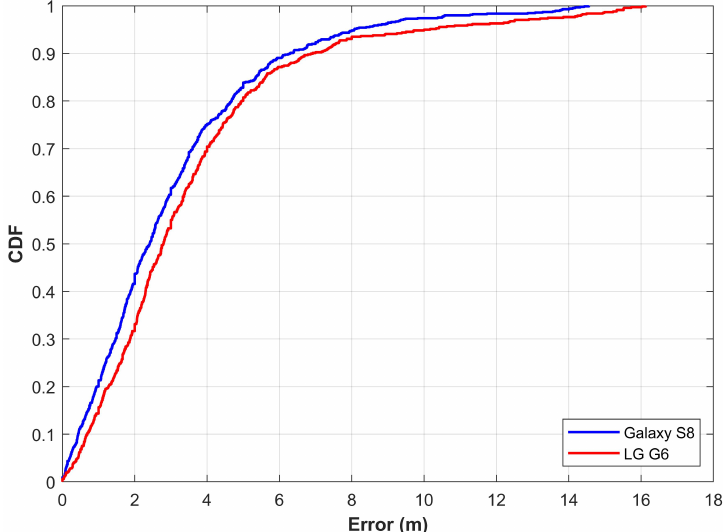
Figure 10. The cumulative distributive function (CDF) graph when using features from magnetic F